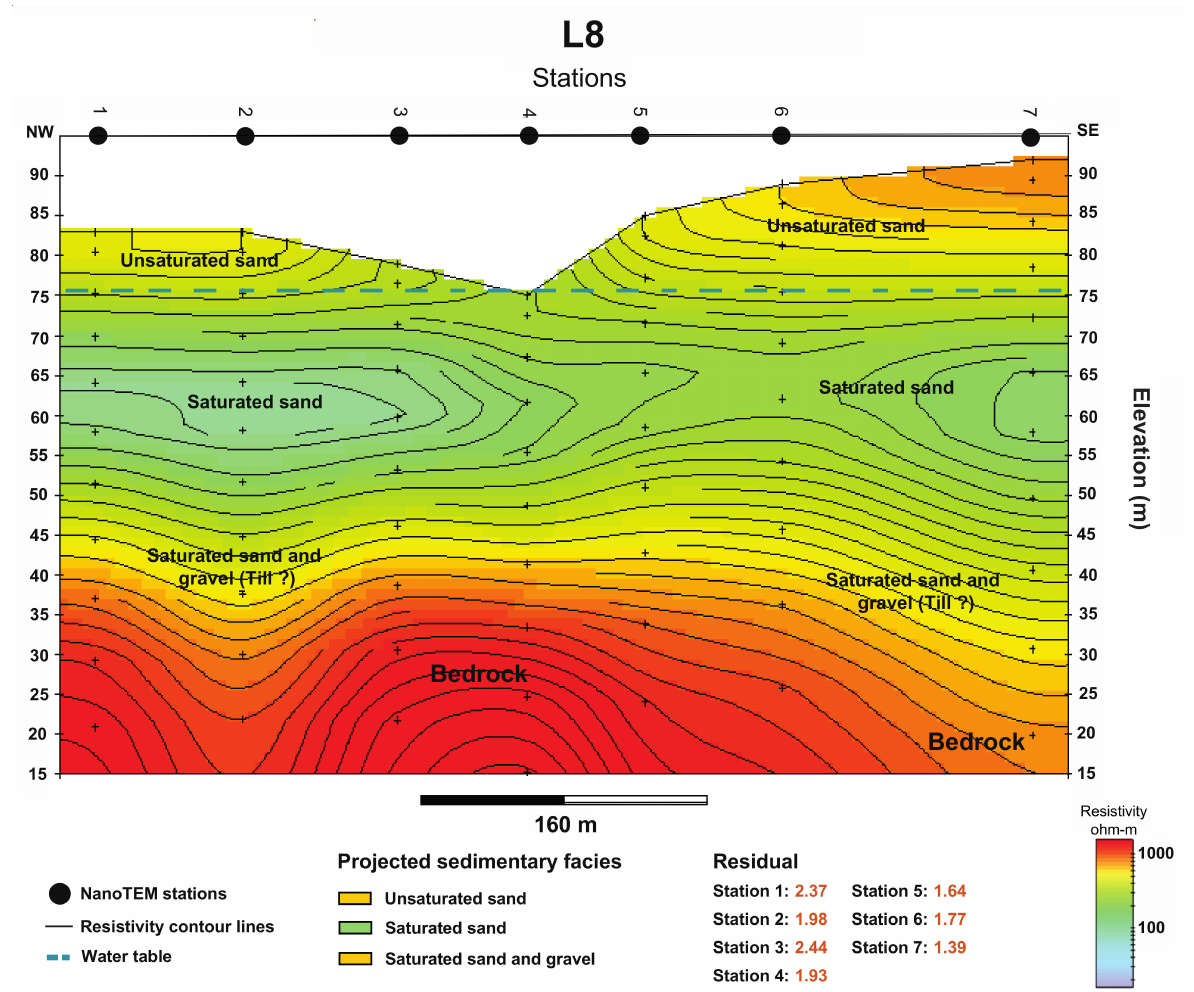
Figure 11. Interpreted 2D Section L8 near Saint-Narcisse and Saint-Genevi è ve-de-Batiscan, Quebec. The surface deposit elevation is obtained from lidar